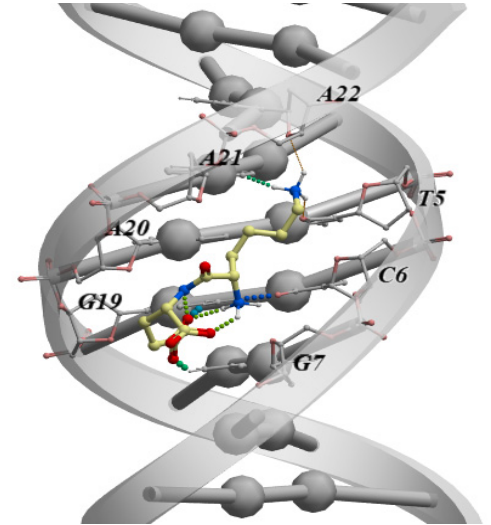
Figure 2. The classical B-shaped binding of the KE dipeptide to the “TCGA” region of the dsDNA. The measurement was performed by molecular modeling and ligand docking using the ICM-Pro software (Molsoft LLC, San Diego, CA, USA).